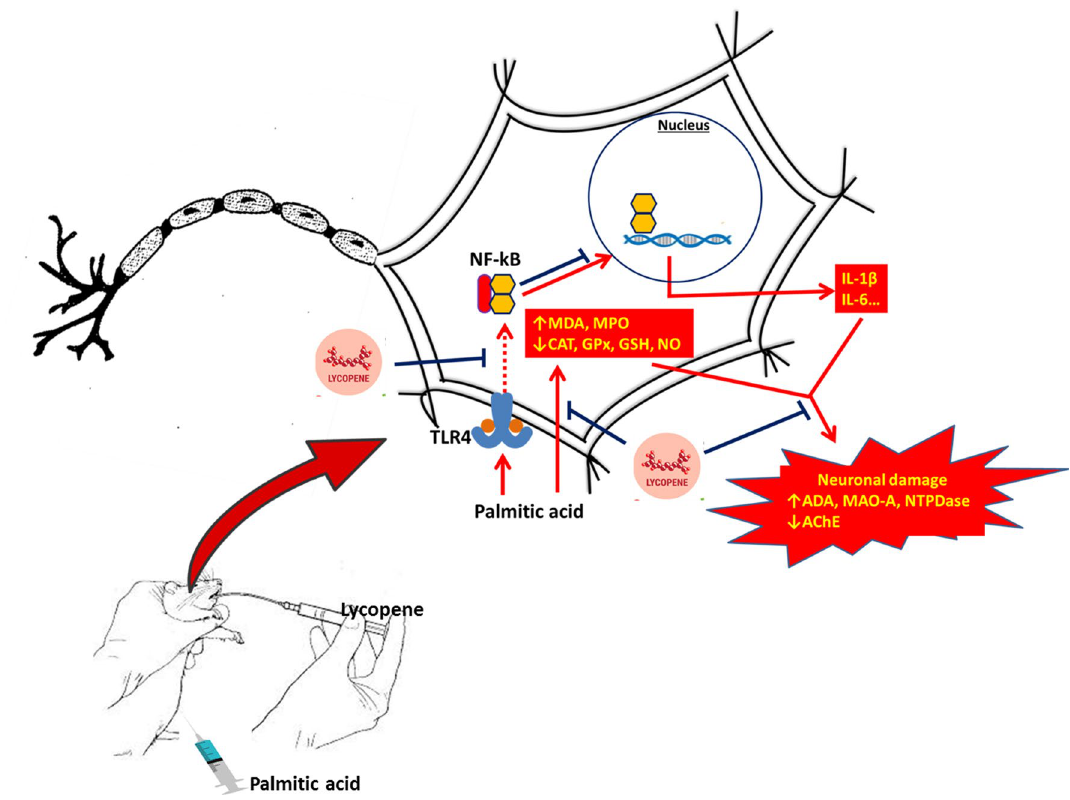
Figure 7. Graphical